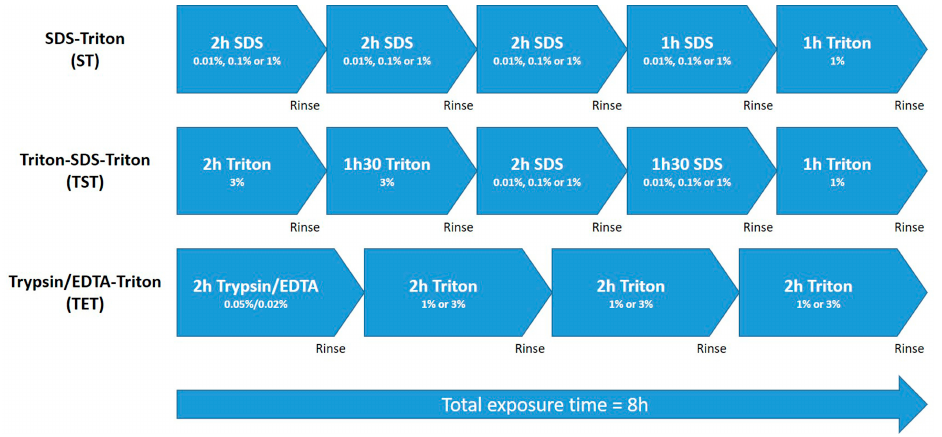
Figure 1. Schematic representation of decellularization processes. Total exposure time to decellularization solutions was eight hours in each case, punctuated by rinse steps in dH 2 O.